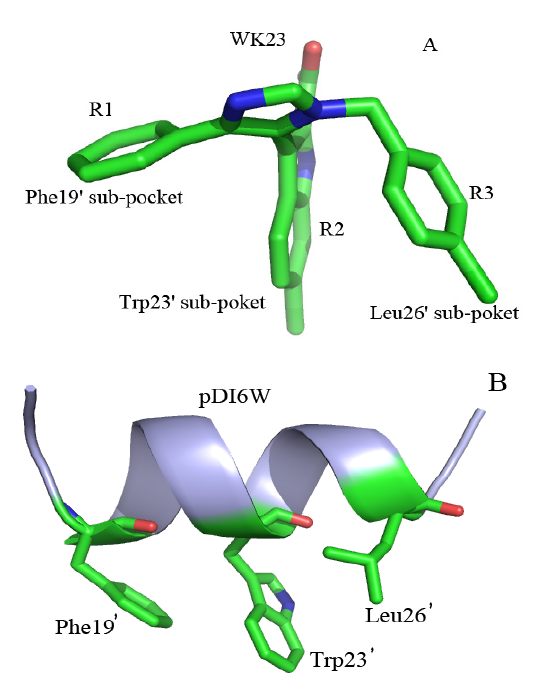
Figure 2. Structures of inhibitors. ( A ) Non-peptide inhibitor WK23 is shown in sticks and green; ( B ) peptide inhibitor pDI6W is shown in cartoon and light blue, and three residues are shown in stick and